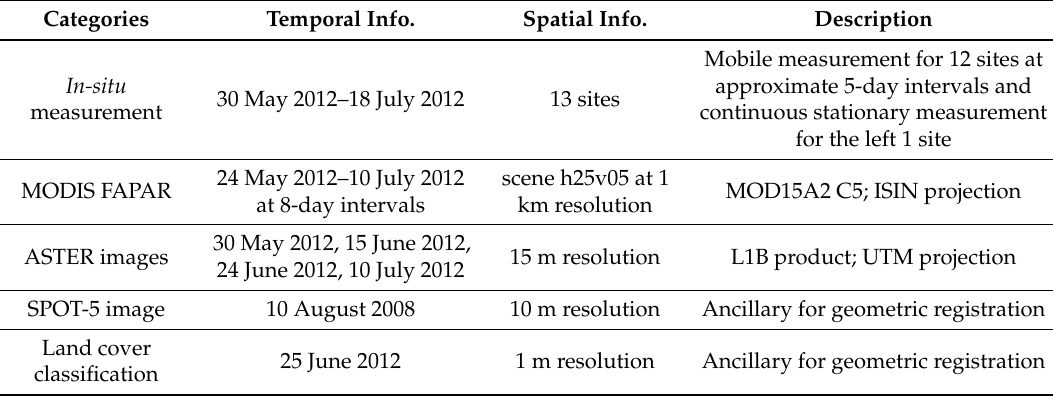
Table 1. Data used in the presented